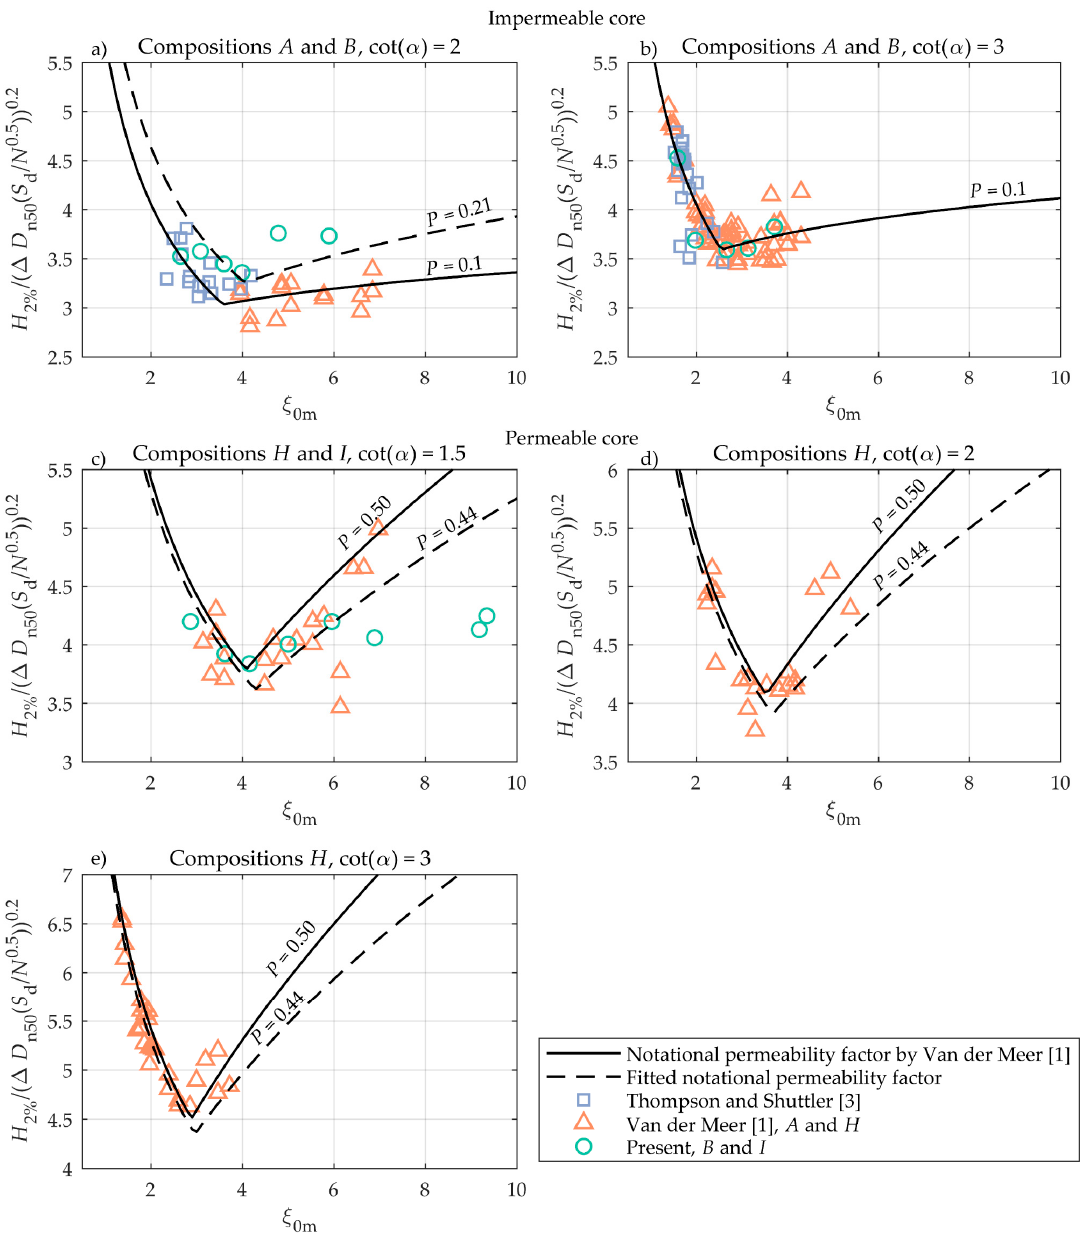
Figure 10. Tests with layer compositions A , B , H and I and front slopes cot( α ) = 1.5, 2 and 3. Continuous lines indicate the given permeability ( P ) by Van der Meer [1]. Dashed lines indicate fitted values of P derived from the Van der Meer formulae. Markers indicate the results.